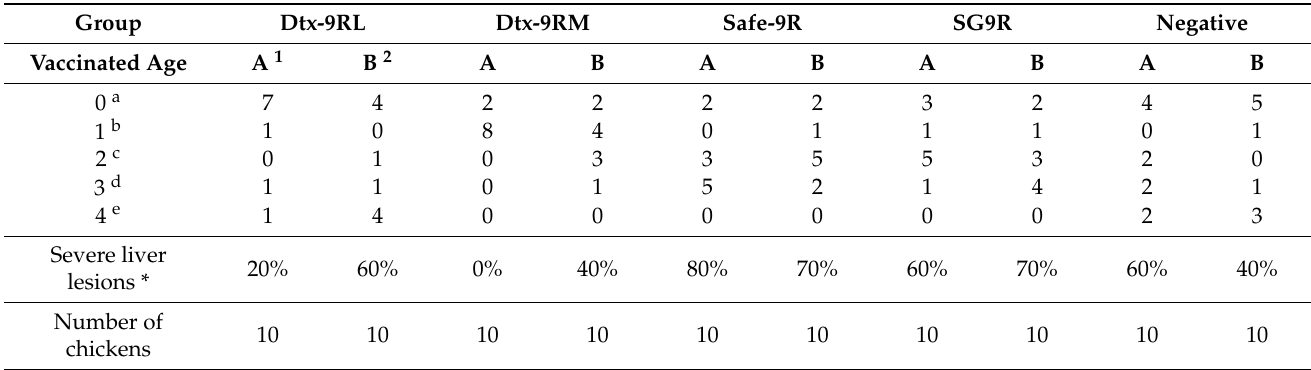
Table 3. Protective efficacy of live detoxified vaccines.